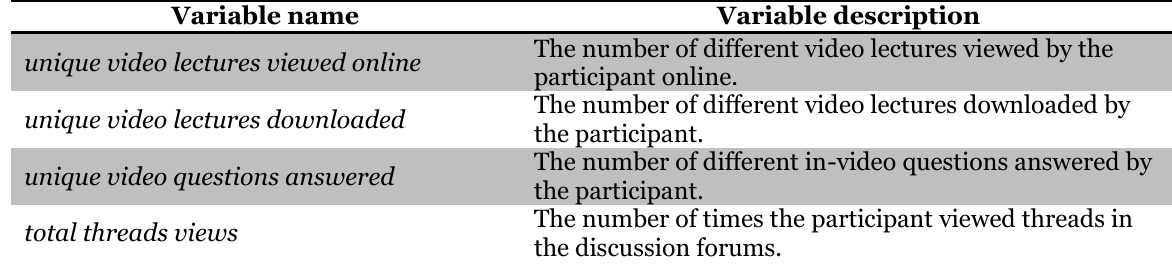
The Variables That Were Computed per